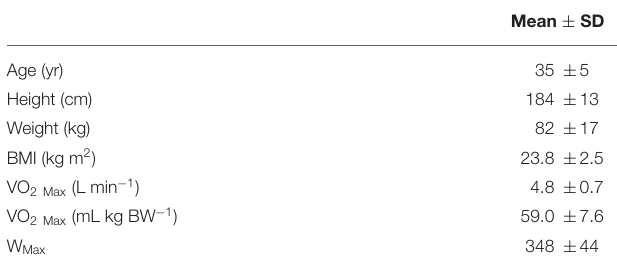
TABLE 1 | Participant